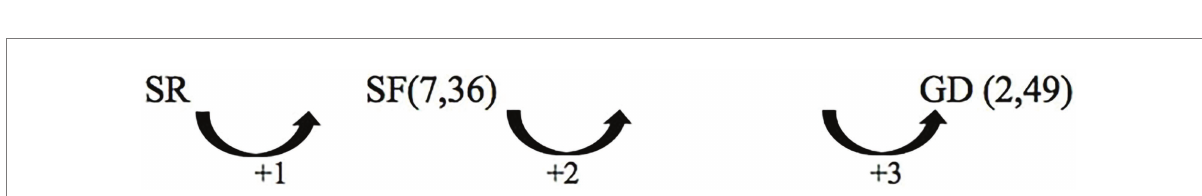
FIGURE 11 Association pattern between the focal conduct shot “R6mts” and the conditioned conduct attack result. “Efic” and opponent response “Rep,” considering game time factor/variable, in all national teams. SR, no shot; SF, no finalization; GD, goal-to-goal